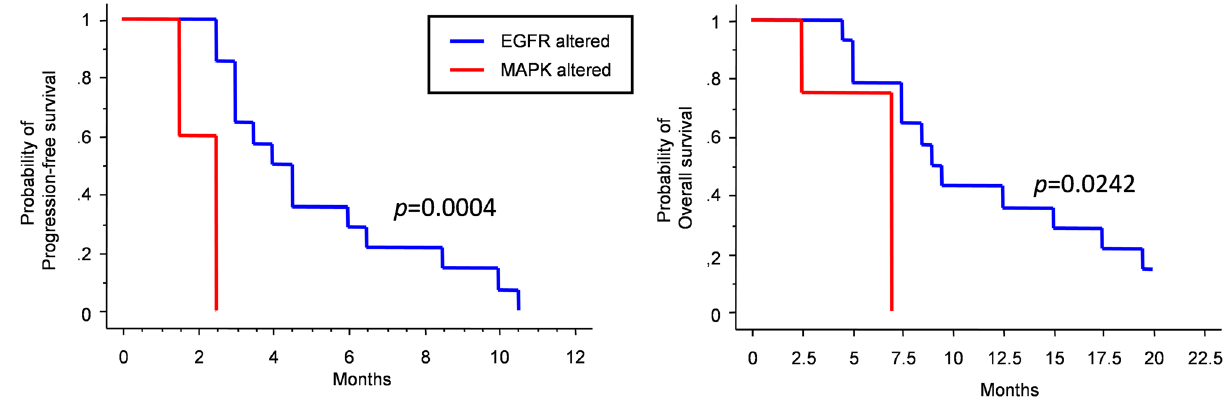
Figure 2. Kaplan–Meier survival curves for PFS (left) and OS (right) depending on pathway alteration at next- generation sequencing analysis combined with EGFRvIII